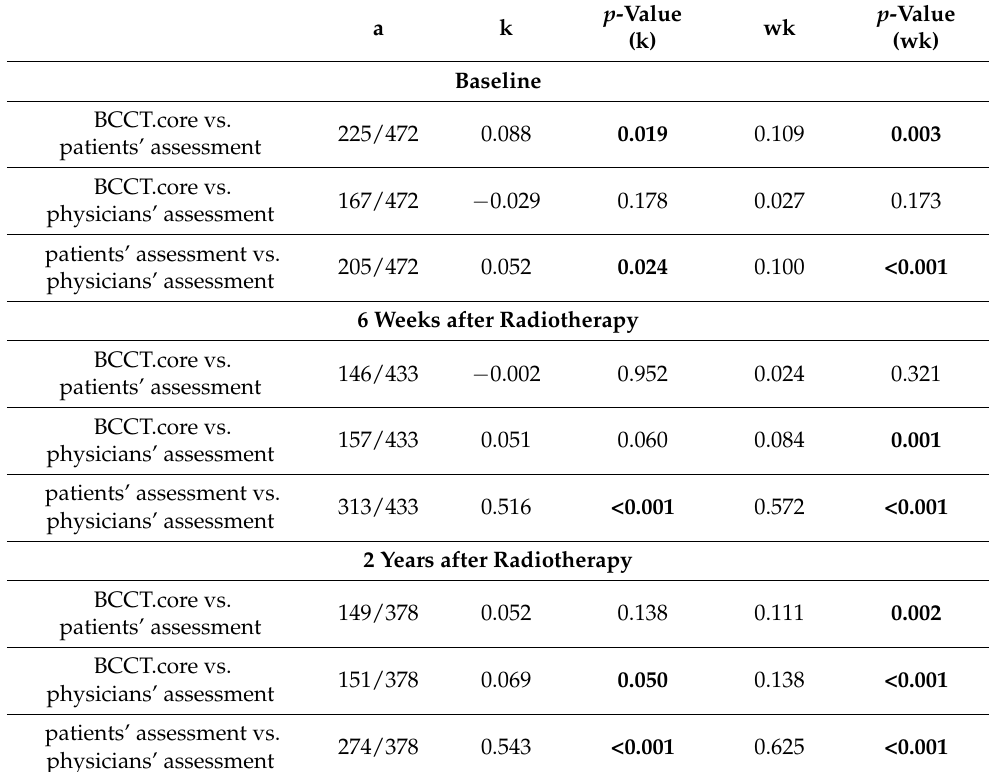
Table 4. Agreement of BCCT.core software results with patients’ or physicians’ assessment scores, and agreement of patients’ assessment scores with physicians’ assessment scores, at the baseline, 6 weeks, and 2 years after radiotherapy (four-point scale: excellent–good–fair–poor). a